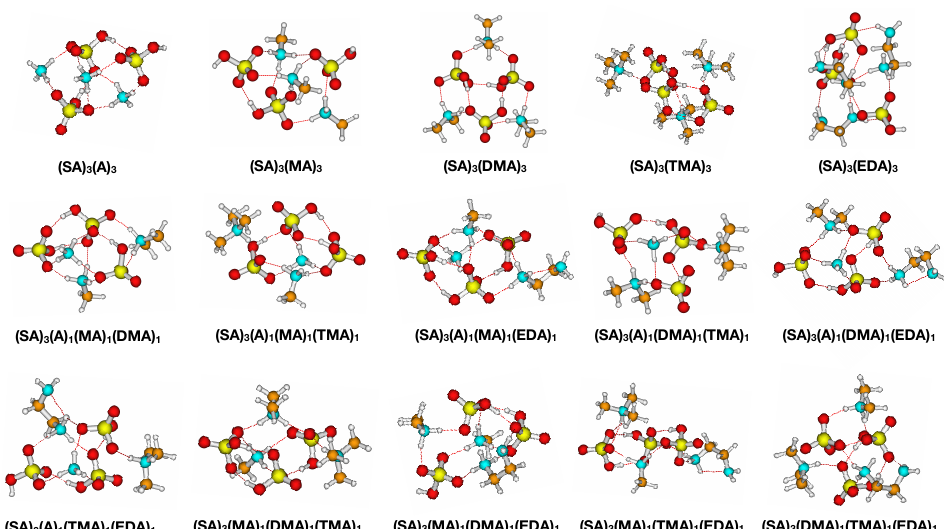
Figure 1. The identified lowest free energy cluster structures (at 298.15 K and 1 atm) at the ω B97X- D/6-31++G(d,p) level of